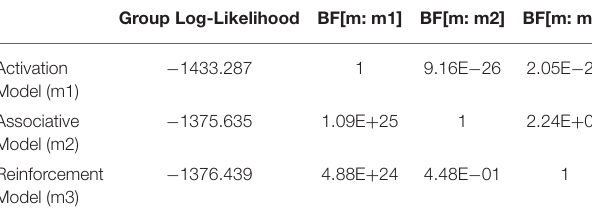
TABLE 5.2 | Summary of log-likelihood and BF statistics for experiment